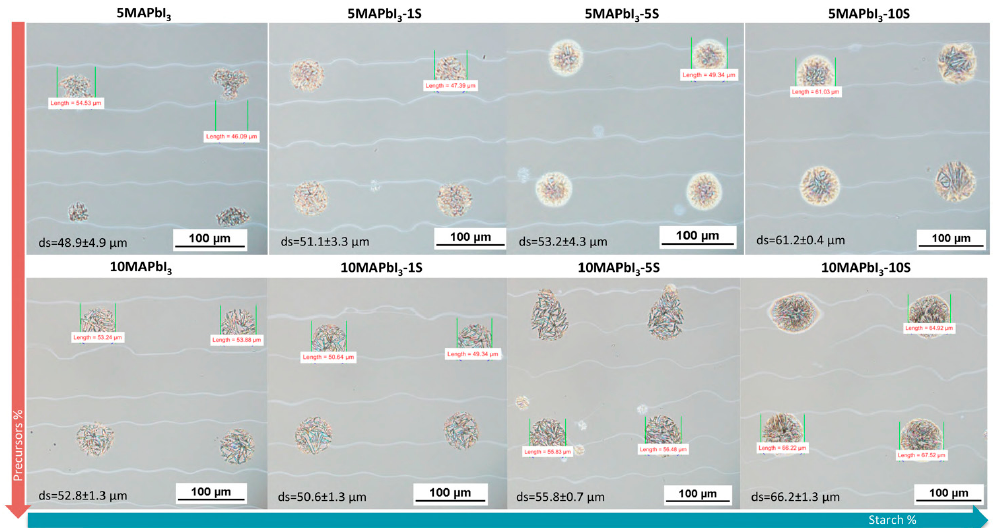
Figure 2. Droplets ejected from the nozzle for the different inks explored.